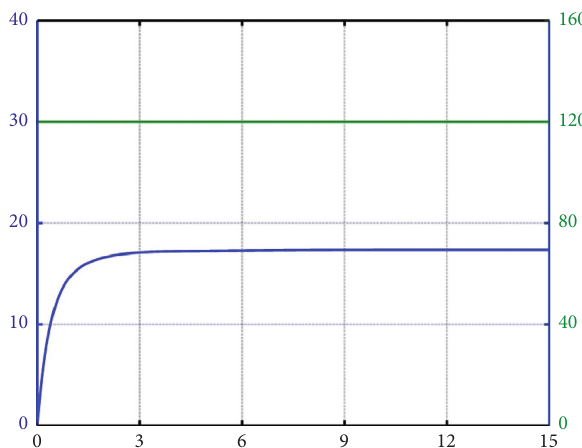
Figure 7: Trajectories of practical energy consumption and total energy supply for the leaderless case.